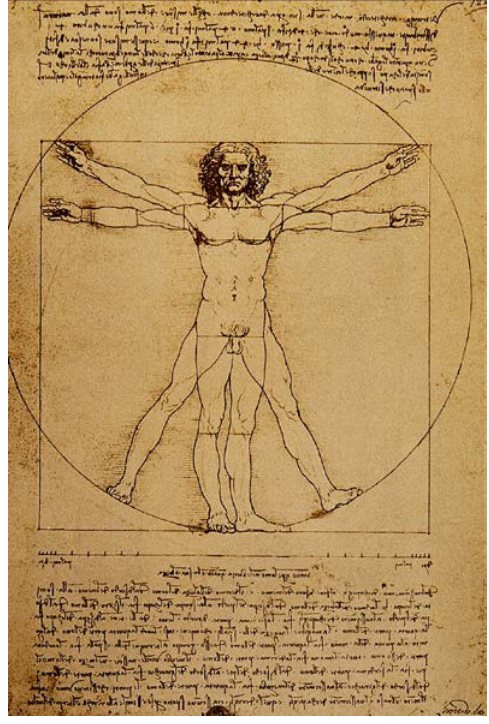
Figure 6. Vitruvian Man. Leonardo da Vinci. Source: Wikimedia Commons.